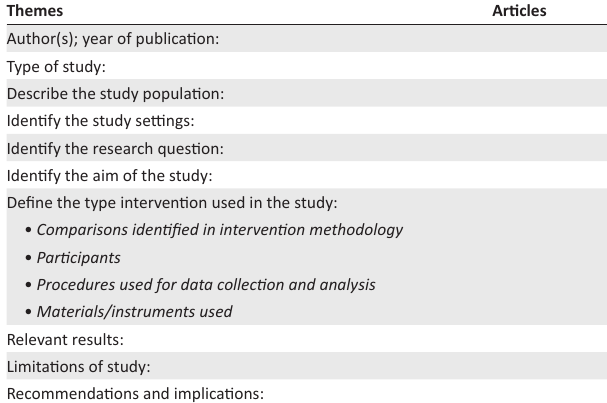
TABLE 1-A1: References of 12 studies included in scoping review. Number